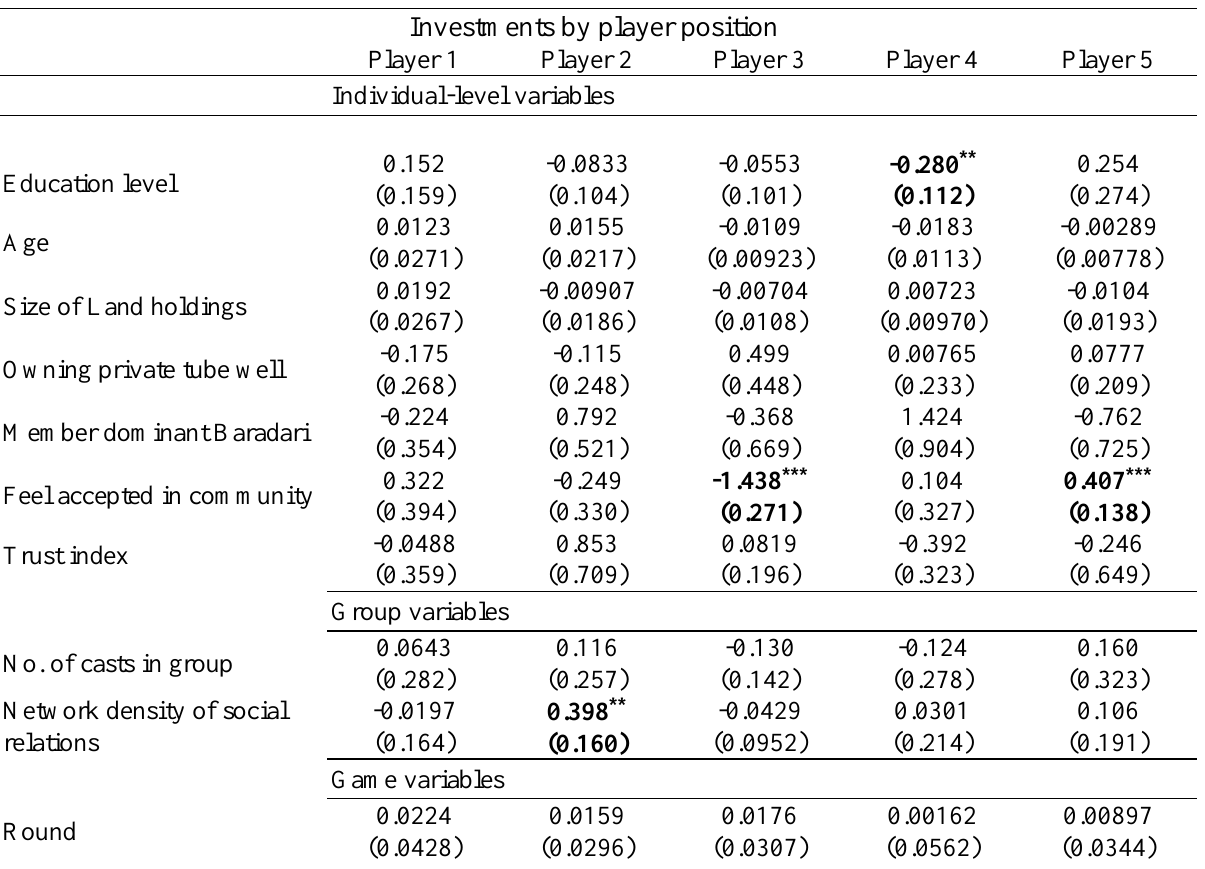
Table A4.2. Mixed-effects regression models explaining the tokens invested for provision of CPR by player position over all experiment rounds (coefficients with robust standard errors